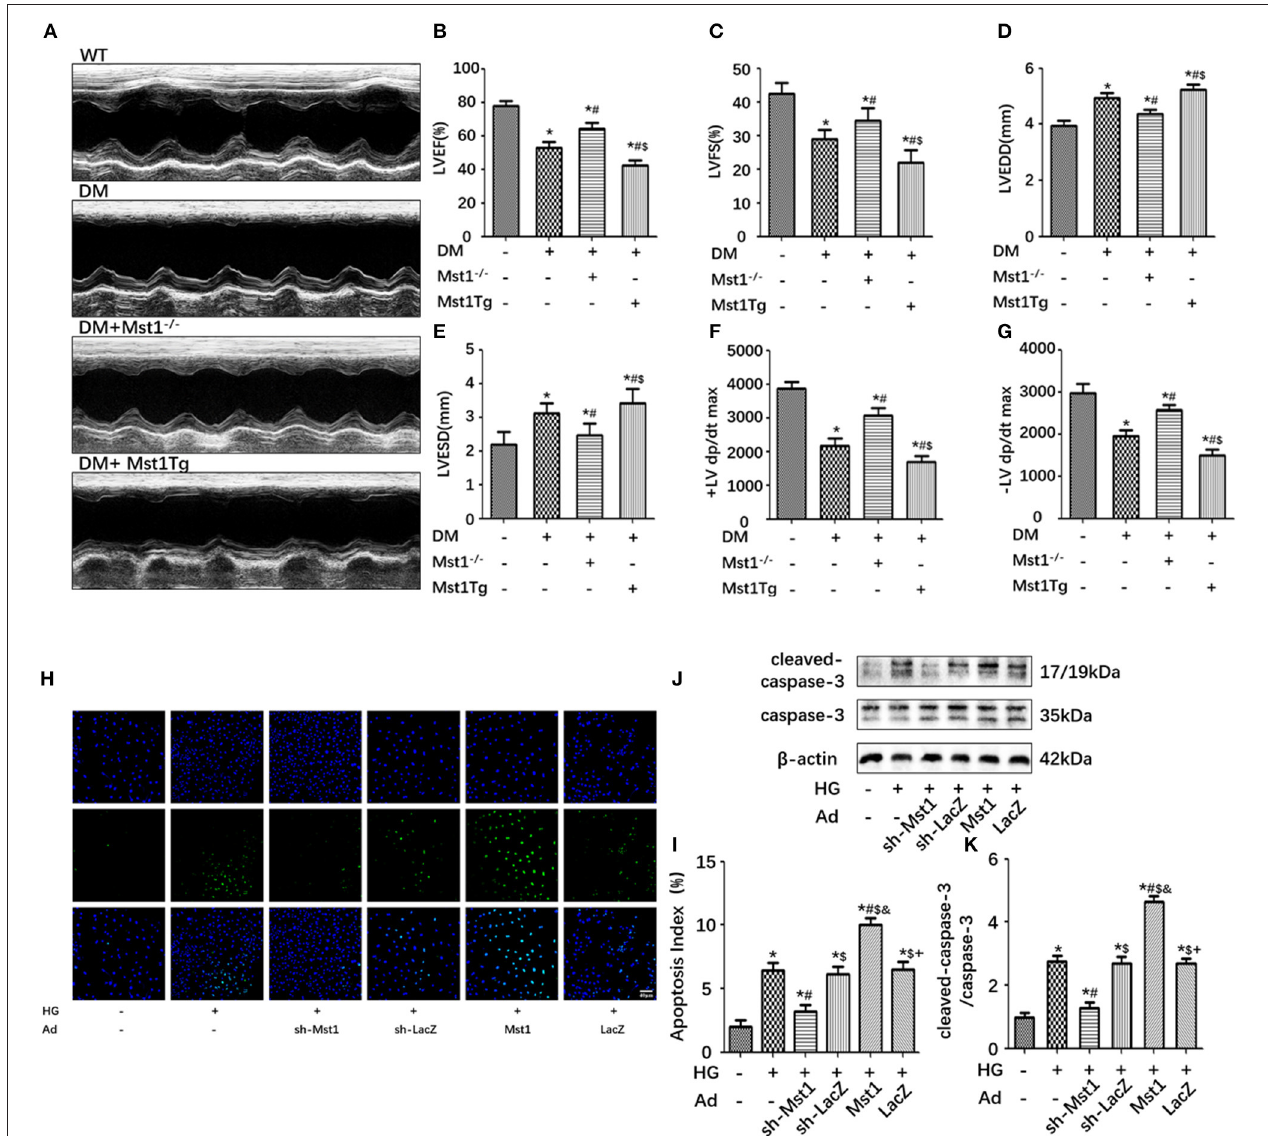
FIGURE 1 | Mst1 inhibition alleviates cardiac dysfunction and cardiomyocyte apoptosis in diabetic mice. (A) Representative images of echocardiography. (B) Measurements of LVEF (%). (C) Measurements of LVFS (%). (D) Measurements of LVEDD (mm). (E) Measurements of LVESD (mm). (F) Hemodynamic evaluation of + LV dp/dt max. (G) Hemodynamic evaluation of -LV dp/dt max. The columns and error bars represent the means and SEM. * P < 0.05 vs. WT; # P < 0.05 vs. DM; $ P < 0.05 vs. DM + Mst1 − / − . (H) Representative images of TUNEL staining in primary cardiomyocytes (scale bar: 40mm). (I) Quantitative analysis of the apoptotic index (percentage of TUNEL-positive nuclei, %). (J) Representative western blots showing expression of cleaved-caspase 3, caspase 3 and β -actin (loading control) proteins. (K) Quantitative analysis of the ratio of cleaved-caspase 3/caspase 3. The columns and error bars represent the means and SEM. * P < 0.05 vs. Con; # P < 0.05 vs. HG; $ P < 0.05 vs. HG + Ad-sh-Mst1; and P < 0.05 vs. HG + Ad-sh-LacZ; and + P < 0.05 vs. HG +